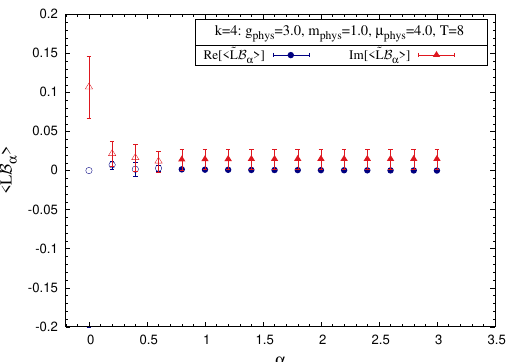
Table 5 . Expectation value of e L B α for supersymmetric anharmonic oscillator with parameters m phys = 10 . 0 and g phys = 100 . 0 . Simulations were performed for different lattice spacings with β = 1 and α = 0 .